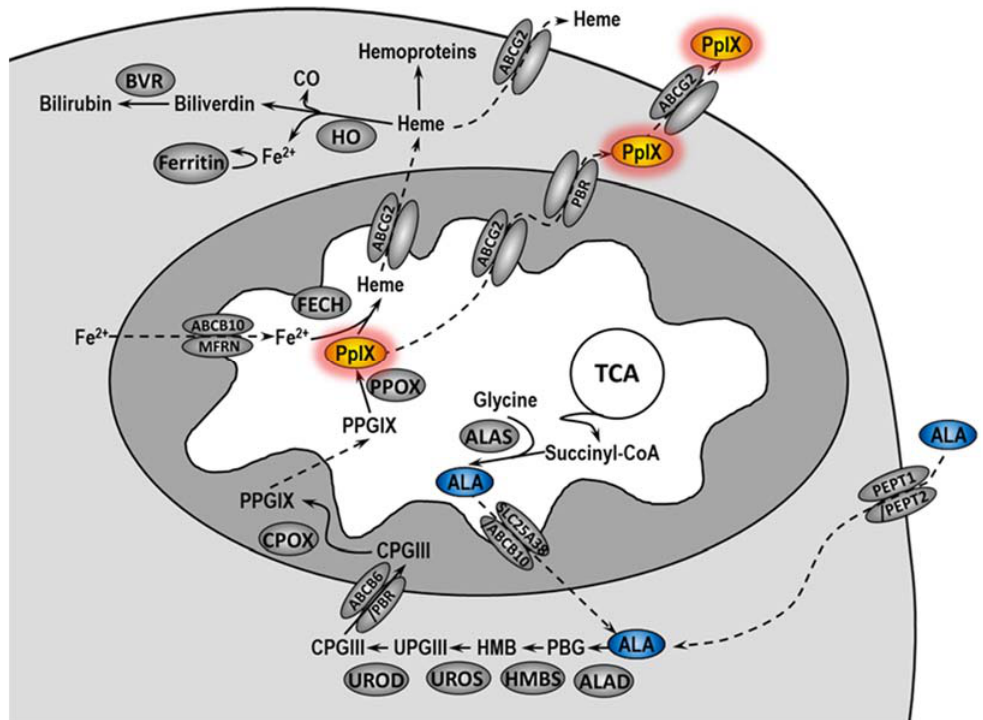
Figure 1. Heme metabolism pathway. ALA is normally synthetized in the mitochondrial matrix by combining glycine with succinyl ‐ CoA in a reaction catalyzed by ALA synthase (ALAS). After passing into the cytoplasm, ALA is converted into coproporphyrinogen III (CPGIII) as a result of numerous changes. Exogenously administered 5 ‐ ALA is delivered to the cytoplasm of cells by peptide transporter 1 and 2 (PEPT1 and PEPT2). CPGIII is transported to the intermembrane space of mitochondria where it is converted by coproporphyrinogen oxidase (CPOX) to protoporphyrinogen IX (PPGIX) and then in the mitochondrial matrix to PpIX by protoporphyrinogen oxidase (PPOX). Next, ferrochelatase (FECH) leads to the formation of heme by incorporating iron into PpIX. PpIX and heme can be released from the cell via the ABCG2 transporter. Heme in the cell is used to create hemoproteins or it is degraded by heme oxygenase (HO), leading to the release of biliverdin, CO, and Fe 2+ . Iron ions may be bound and stored by ferritin. Biliverdin is converted to bilirubin by biliverdin reductase (BVR). ABCB10—ABC subfamily B member 10; ALAD—5 ‐ aminolevulinic acid